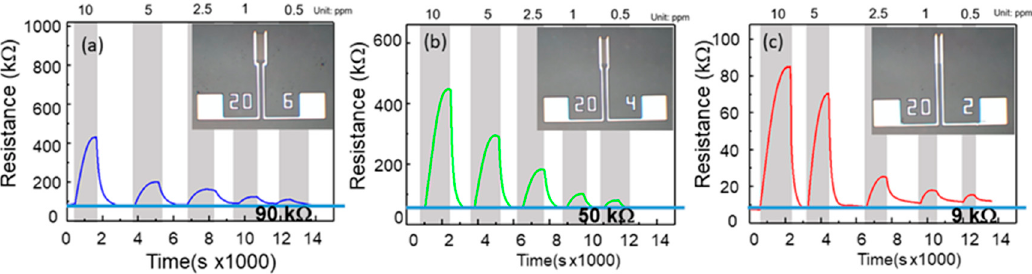
Figure 6. Resistance as a function of injection gas concentration for the gas sensors with a fixed channel width of 200 μ m and varying lengths of ( a ) 60 μ m, ( b ) 40 μ m, and ( c ) 20 μ m. Insets show the structures of the devices.